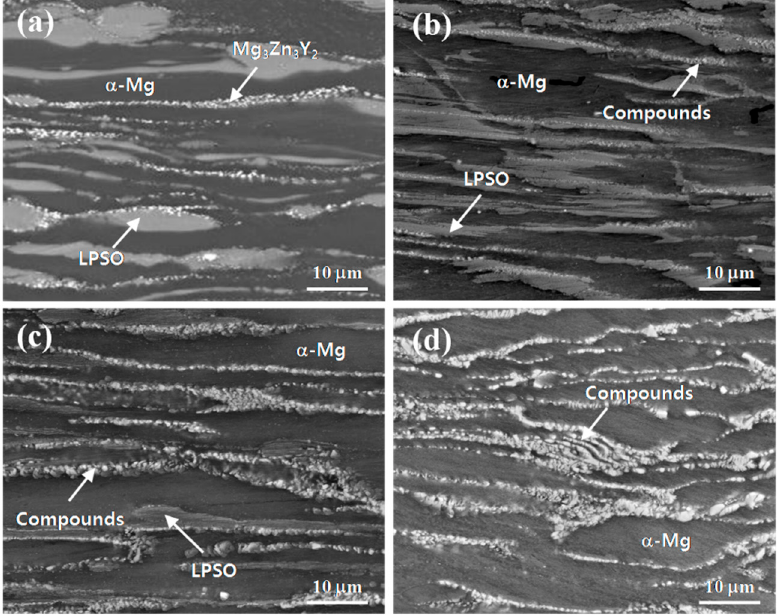
Figure 4. SEM microstructure of the extruded alloys: ( a ) Mg 88.5 Zn 5 Y 6.5 ; ( b ) Mg 88.5 Zn 5 Y 5.0 Yb 1.5 ; ( c ) Mg 88.5 Zn 5 Y 3.5 Yb 3.0 ; ( d ) Mg 88.5 Zn 5 Y 2.0 Yb 4.5 .